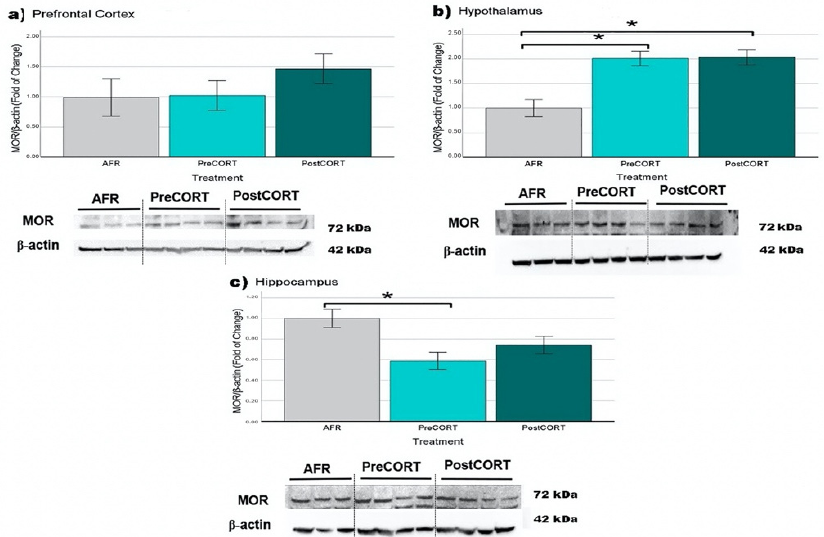
Figure 15. µ -Opioid Receptors (MOR) expression. Histograms and representative bands of MOR expression in ( a ) prefrontal cortex, ( b ) hypothalamus and ( c ) hippocampus in AFR ( n = 5, prefrontal cortex; n = 6, hypothalamus; n = 7, hippocampus); PreCORT ( n = 8, prefrontal cortex; n = 8, hypothalamus; n = 8, hippocampus) and PostCORT ( n = 8, prefrontal cortex; n = 8, hypothalamus; n = 8, hippocampus) subjects (* p < 0.05). Each lane corresponds to different mice. Data are presented as mean ± SEM (* p < 0.05).